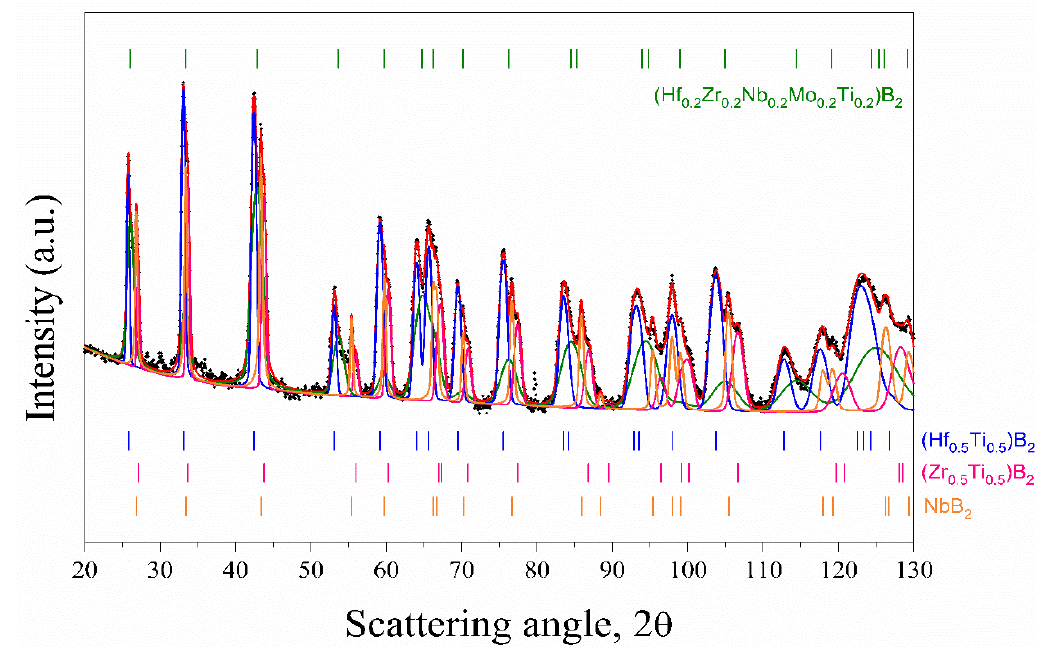
Figure 1. X-ray diffraction (XRD) pattern and related Rietveld refinement of (Hf 0.2 Zr 0.2 Nb 0.2 Mo 0.2 Ti 0.2 )B 2 product obtained by SHS from elemental powders. Table 2. Microstructural parameters and relative amounts of each phase estimated by the Rietveld analysis performed on the as-recorded pattern of the HEB_c product obtained by SHS (Figure 1). R.m.s.: Root mean square.